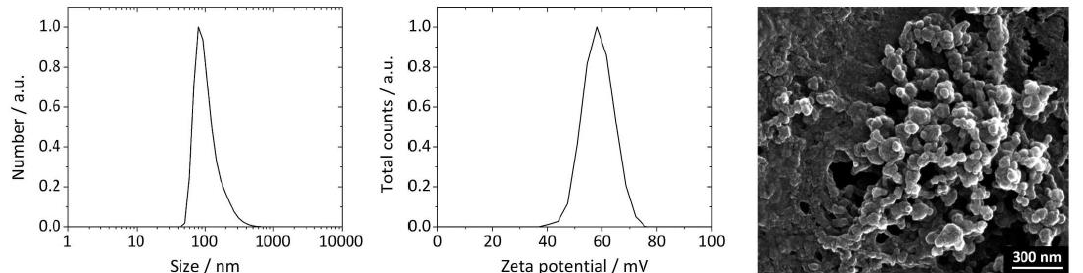
Figure 2. Physicochemical properties of representative ligand-decorated and siRNA-loaded calcium phosphate nanoparticles. Normalized particle size distribution (left) and the corresponding zeta potential (center) by DLS, and SEM micrograph of CaP/PEI-Cy5/siRNAs/SiO 2 /S-IgG-anti-CD69-CTRL nanoparticles (right). DLS and SEM results of all other types of nanoparticles investigated in this study are given in Supplementary Figures S2 and S3. For detailed nanoparticle characterization data, see Tables 1 and 2. Table 1. Characterization data of cRGDfK-decorated calcium phosphate nanoparticles used for in vitro cell targeting and gene silencing of NF- κ B p65 in endothelial cells. Nanoparticles without ligand decoration and siRNA loading (CaP/PEI-Cy5/SiO 2 /SH/H 2 O, CaP/PEI-Cy5/SiO 2 /SH and CaP/PEI-Cy5/SiO 2 ) were used as reference nanoparticles for all types of ligand-decorated nanoparticles. CaP — calcium phosphate, Cy5 — cyanine DLS — dynamic light scattering,